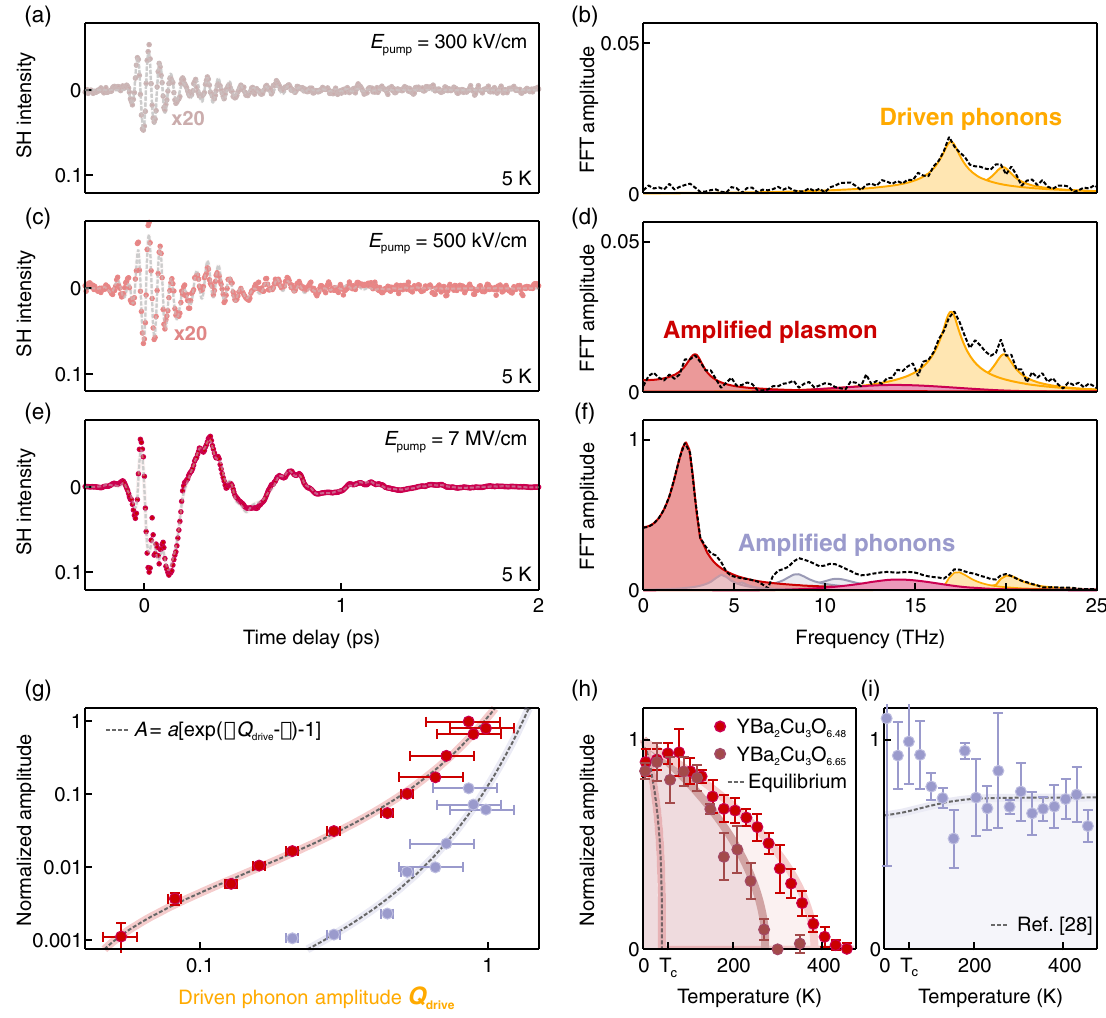
FIG. 2. (a),(b) Coherent SH signal at the lowest excitation field ( E ¼ 0 . 3 MV = cm) and the corresponding Fourier amplitude 48 K. The high-frequency oscillations at 17 and 20 THz (yellow spectrum at T ¼ 5 K, well below the critical temperature T c ¼ peaks) are coherent symmetry breaking apical oxygen vibrations, resonantly driven by the excitation pulse. (c),(d) Coherent SH response at higher excitations fields ( E ¼ 0 . 5 MV = cm) at the same temperature. The peaks at ν 1 ¼ 2 . 5 THz and ν 2 ¼ 14 . 5 THz (red and magenta) are ascribed to coherent oscillations of Josephson plasma waves. (e),(f) The coherent SH response at significantly stronger excitations ( E ¼ 7 MV = cm) show the same coherences of (c) and (b), with additional modes drawn as gray peaks. These additional peaks are dominated by those at 8.6 and 10.5 THz and label additional phonons nonlinearly coupled to the resonantly driven lattice modes. (g) Measured amplitude of the amplified low-frequency JPP J 1 and the amplified plotted as a function of the driven apical oxygen vibration amplitude Q . All quantities were phonon amplitude Q amplified drive extracted from the same time trace, for different strengths of the midinfrared excitation field. The dashed line is an exponential a · ð e α Q drive − β − 1 Þ to the data, where the gain factor α is determined by the strength of the coupling between the fit A ð Q drive Þ ¼ driven phonon and the JPP and β > 0 is the amplification threshold. Error bars represent the standard deviation σ of the amplitudes extracted by numerical fits. (h) Full temperature dependence of the JPP peaks in (d) (shaded area) for YBa 2 Cu 3 O 6 p ffiffiffiffiffiffiffiffiffiffiffiffiffiffiffiffiffiffi . 48 1 − T=T 0 , yielding T 0 ¼ 380 K (red) and YBa 2 Cu 3 O 6 (dark red). The lines are fits to the data with a mean-field approach ∝ . 65 and T ¼ 280 K for YBa 2 Cu 3 O 6 . The dashed line is the temperature dependence of the equilibrium low- for YBa 2 Cu 3 O 6 . 48 . 65 , which disappears at T . (i) Temperature dependence of the amplitude frequency Josephson plasma resonance in YBa 2 Cu 3 O 6 c . 5 of the nonlinearly coupled infrared active phonons at 8.5 and 10 THz. Their temperature dependence from equilibrium infrared , taken from Ref. [28], is shown as a dashed line. The data in (h) and (i) were recorded at an measurements in YBa 2 Cu 3 O 6 . 5 excitation peak field of ∼ 7 MV = cm. Error bars represent the standard deviation σ of the amplitudes obtained by repeating the experiment under equivalent